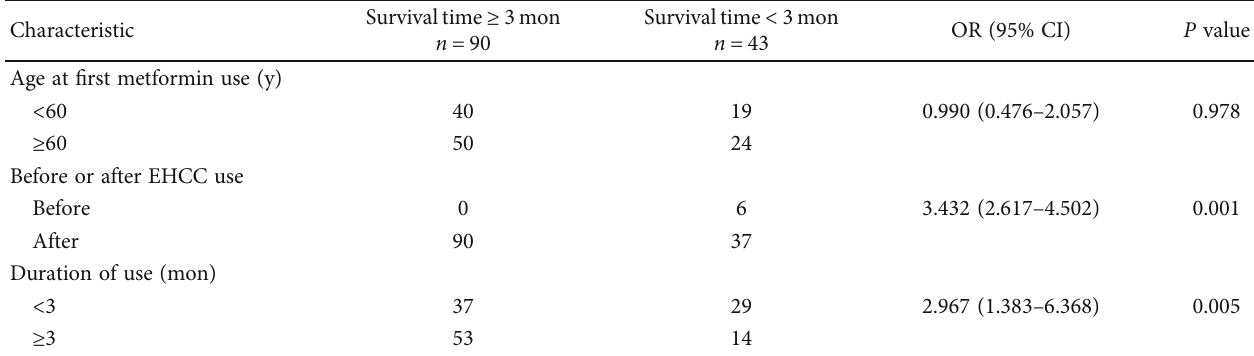
Table 3: ORs and 95% CIs for metformin use in study